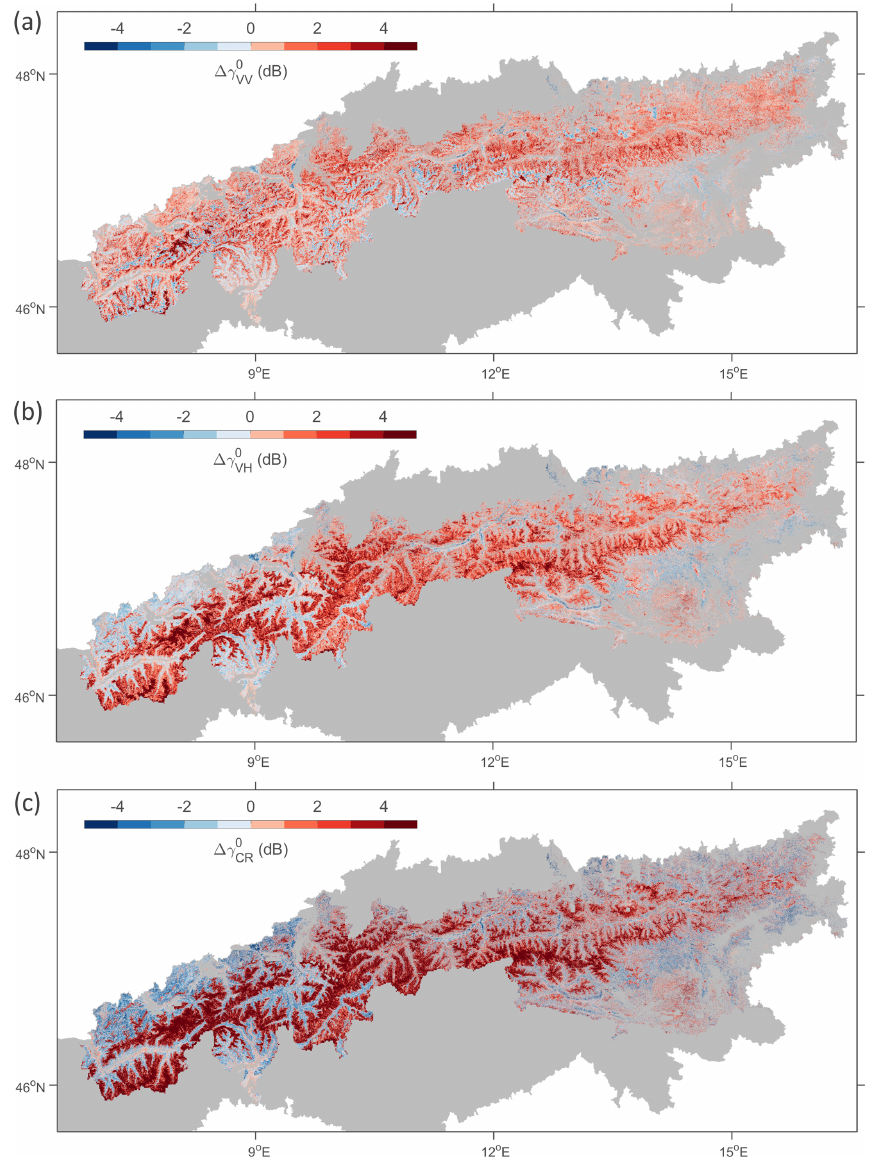
Figure 5. Changes in 100m S1 backscatter ( γ 0 ; dB) with snow accumulation: the γ 0 of the day with the maximum simulated snow depth (between August and April) minus the γ 0 of the first day with snow cover, for (a) VV polarization, (b) VH polarization, and (c) the cross- polarization ratio (CR). Wet snow conditions detected by S1 are